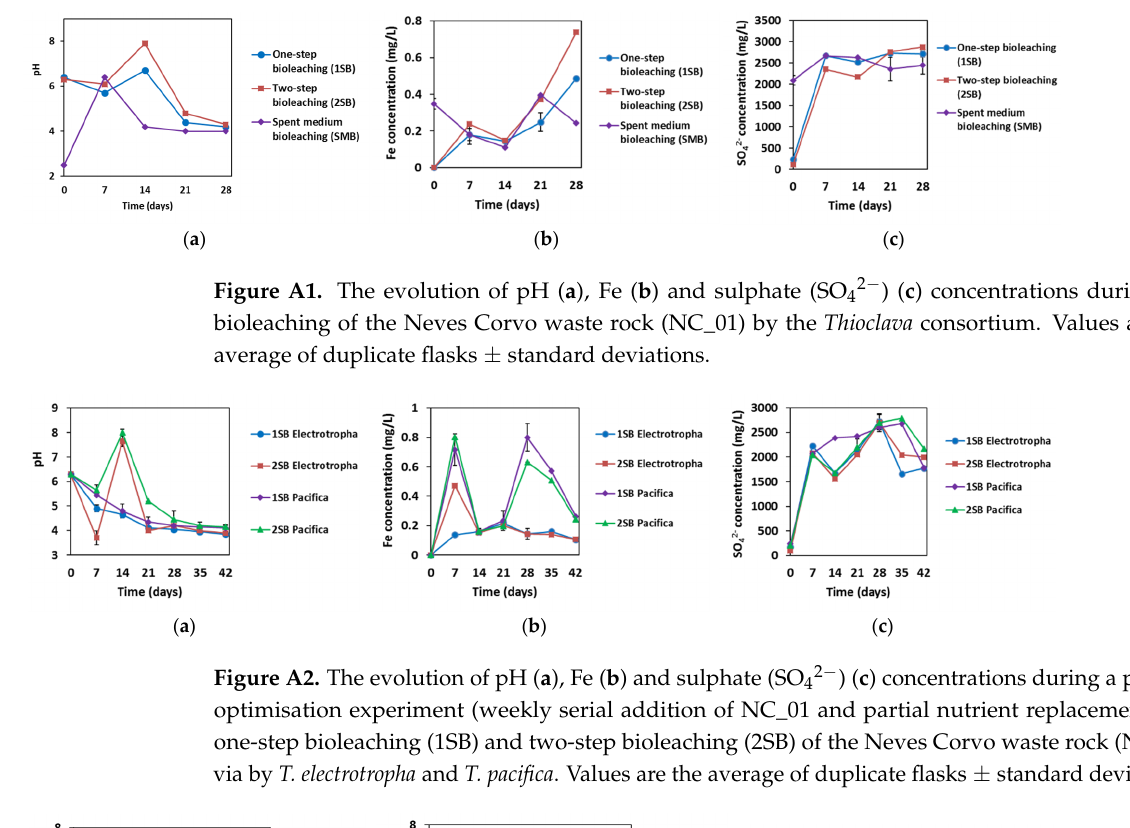
ples ± standard deviations.